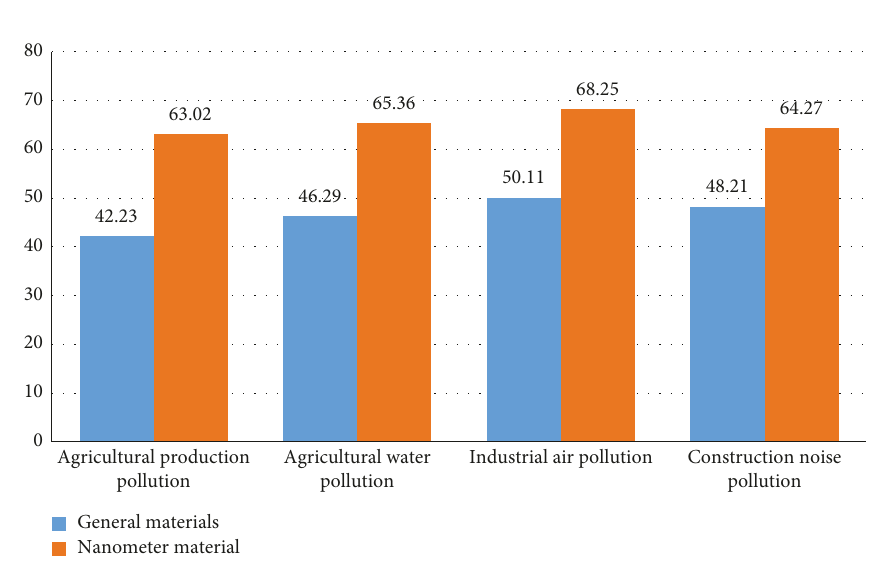
Figure 2: Analysis of data on environmental pollution control by different